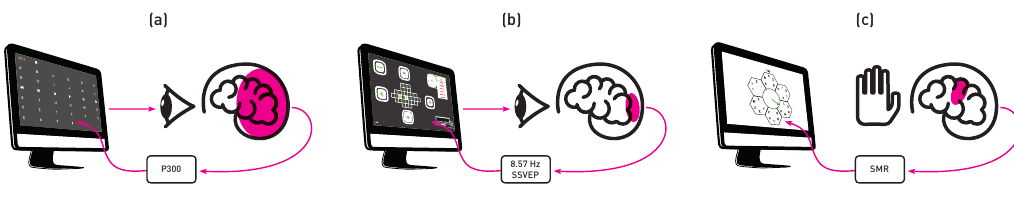
Figure 1. Schematic representation of three major Brain–Computer Interface (BCI) paradigms: ( a ) P300 paradigm. The oddball paradigm causes a P300 signal in the brain of the user which is then interpreted by the BCI system, resulting in the selection of the desired letter; ( b ) Steady-State Visual Evoked Potential (SSVEP) paradigm. Five different frequencies are shown on the screen in this example, as discussed later. When the user gazes at one of them, an SSVEP signal with the same frequency (as well as its harmonics) is elicited in the visual cortex of the brain. The measured electroencephalogram (EEG) data are analyzed by the BCI, and a command is sent to the computer to select the target; ( c ) Motor imagery (MI) paradigm (with a schematic representation of a Hex-O-Spell application, as discussed later). The imagination of the movement of limbs (in this picture an imaginary movement of an arm) induces a sensorimotor rhythm (SMR) signal which is detected and analyzed by the BCI system, and a feedback is sent to the computer to control the movement of the green arrow for letter selection. In this case, the presence of an external stimulus is not